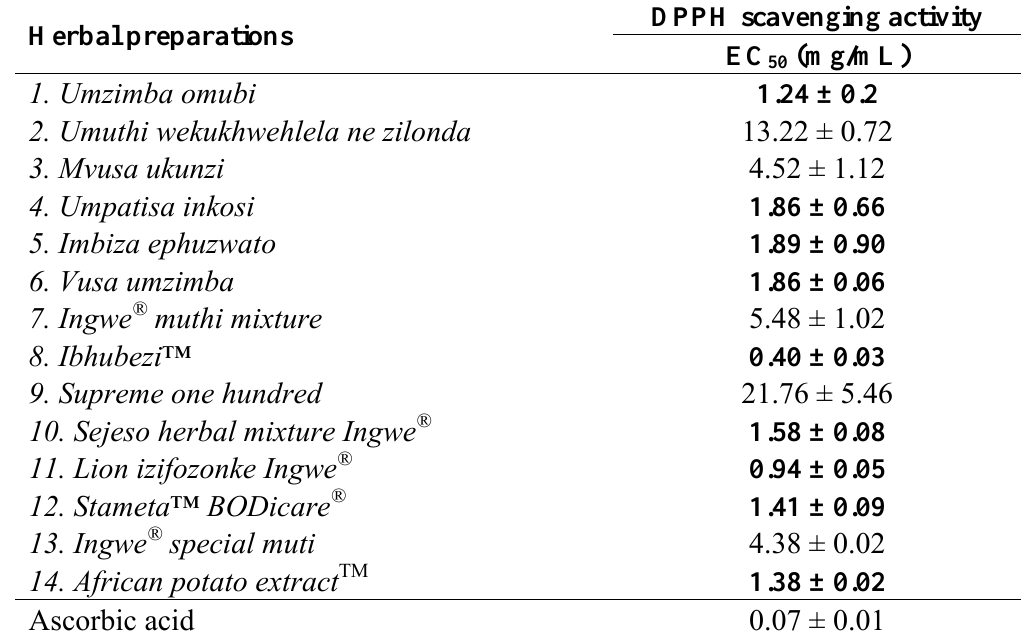
Table 1. DPPH radical scavenging activity (EC sold in Pietermaritzburg,